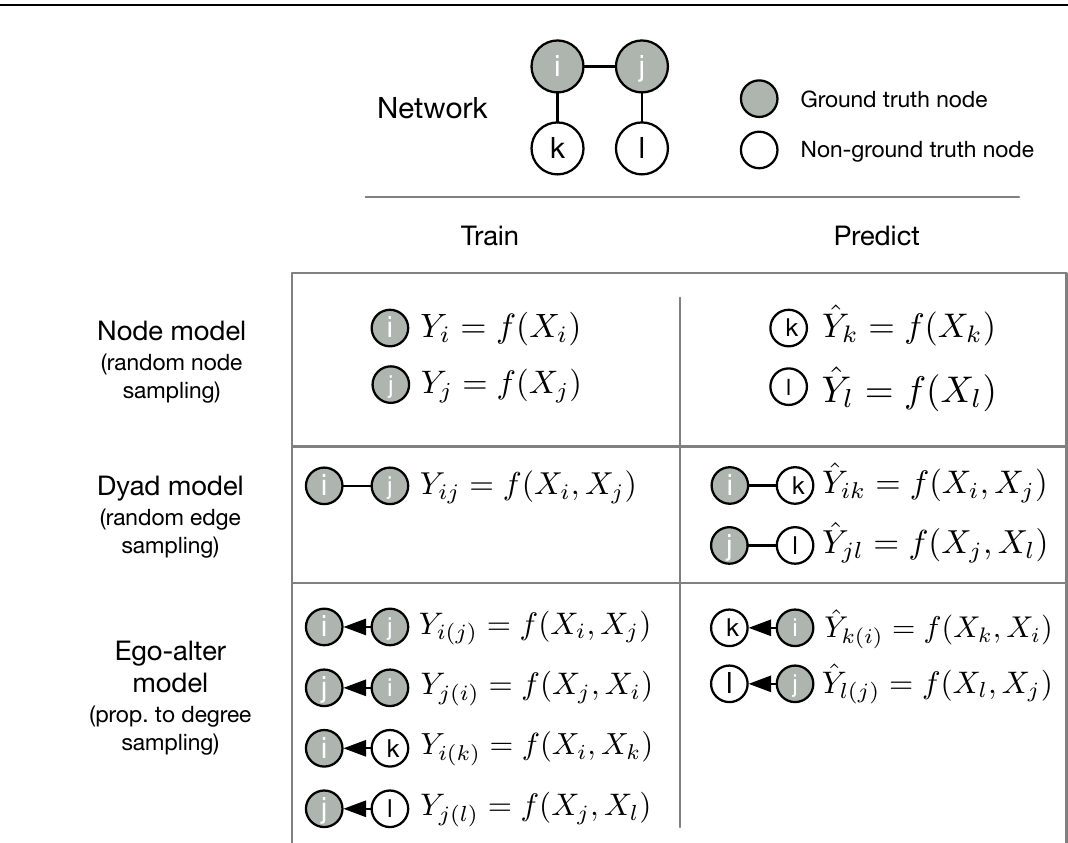
Figure 3: A depiction of how the models studied in this article (node, dyad, and ego–alter) turn a simple network and a ground truth set into a prediction task. The node model predicts each node’s category using node covariates X i . The dyad model predicts dyad categories directly using information on both ego and alter X i , X j . The ego–alter model predicts each node category for each neighbor of the focal node, using ego and alter covariates X i , X j